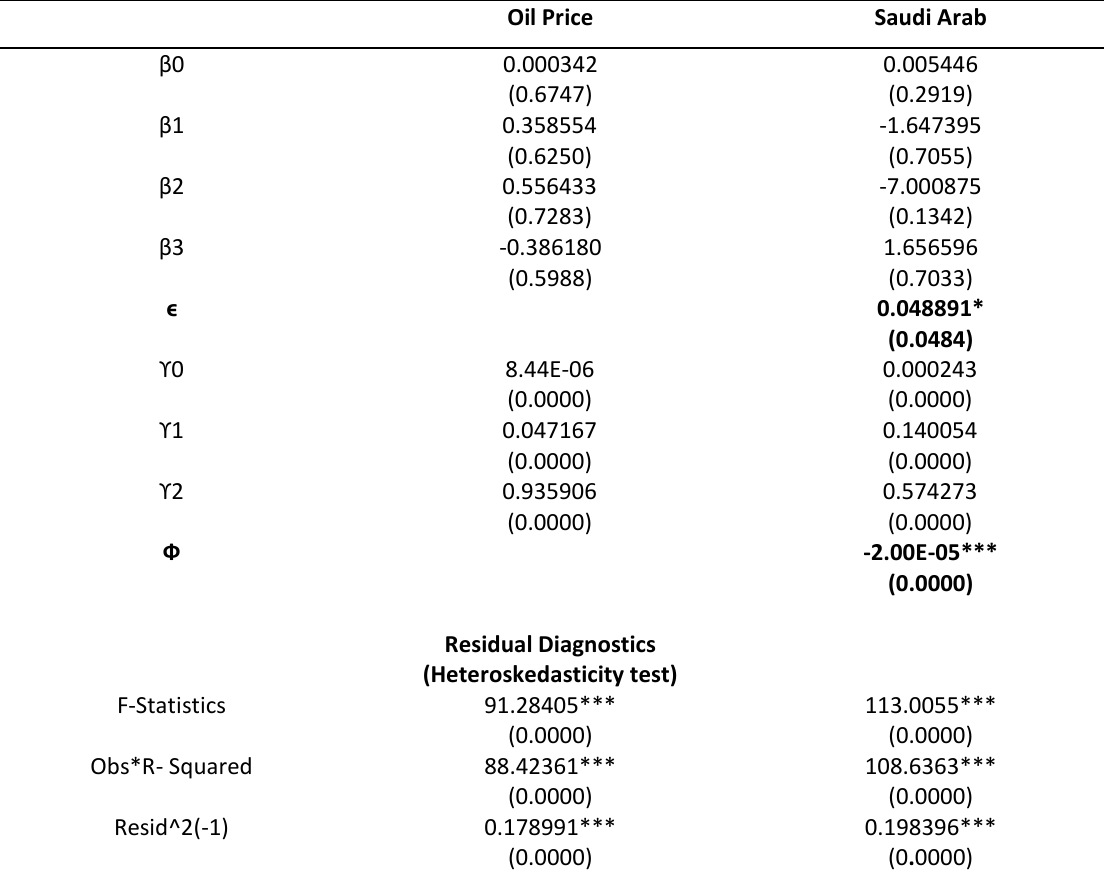
Table 6. Mean and Volatility spillovers from Oil Market Price to Saudi Arab Equity Market estimated from an ARMA (1, 1)–GARCH (1, 1)–in–mean model (December 2001 to June